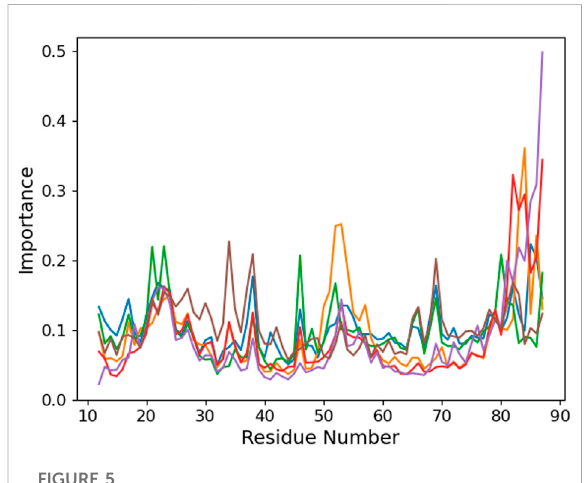
FIGURE 5 Per-proteinresidueimportancefrom thePCAanalysisfor the six studied RNA sequences: control (blue), ° GCCCUG ° G (orange), GCCCU ° GG (green), ° GCCCUGG (red), GCCCUG ° G (violet), and ° GCCC ° GGG (brown).